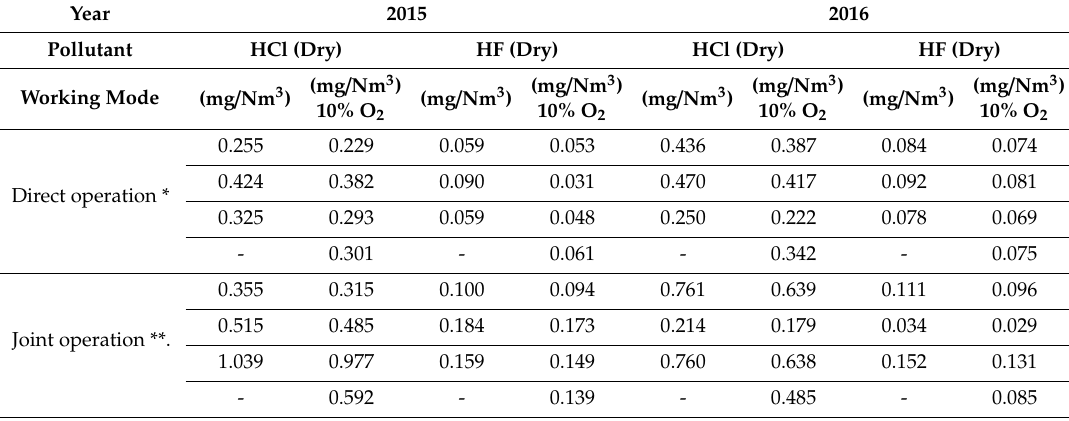
Table 1. Measurement results of HCl and HF of the rotary kiln at first cement factory, Romania, for 2015 and 2016. 2015 2016